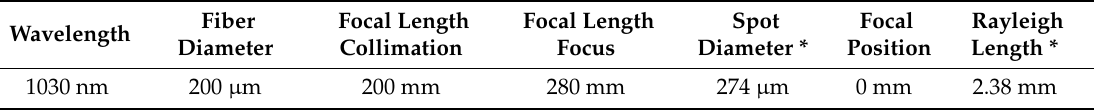
Table 2. Laser properties and